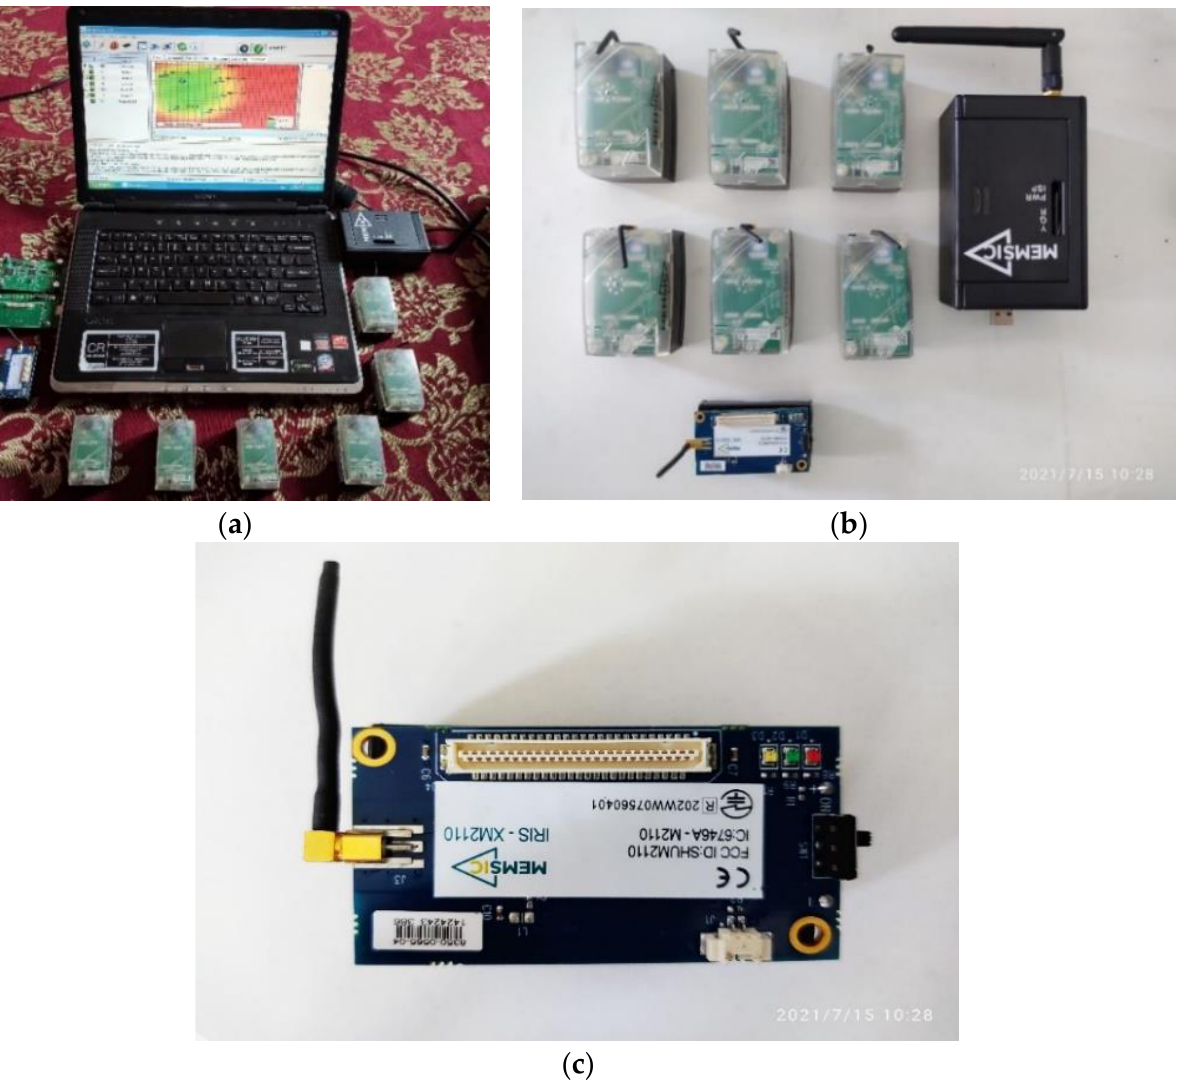
Figure 6. ( a ) IoT Environment; ( b ) IoT Motes and Gateway; ( c ) IoT Mote.